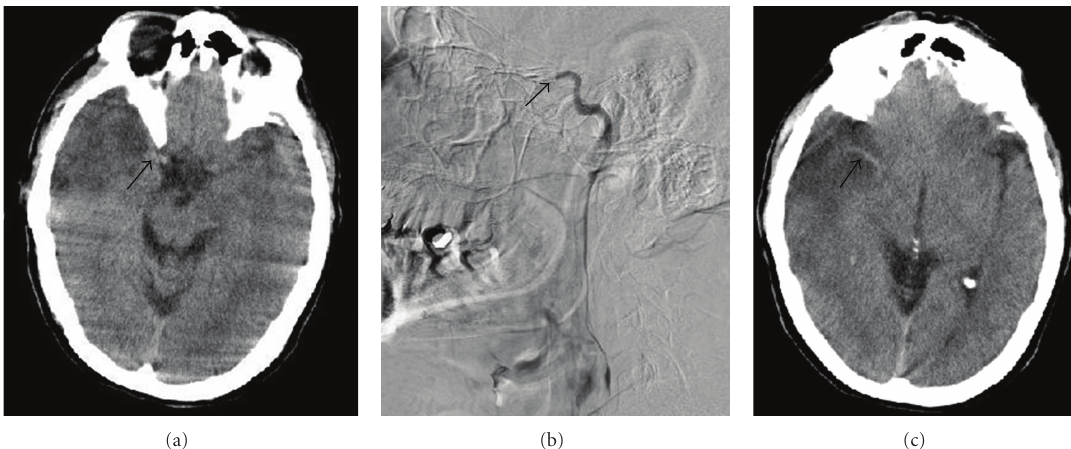
Figure 1: (a) NCCT demonstrating HICAS (arrow). (b) CT Carotid Angiogram demonstrating corresponding terminal carotid occlusion (arrow). (c) NCCT demonstrating HMCAS